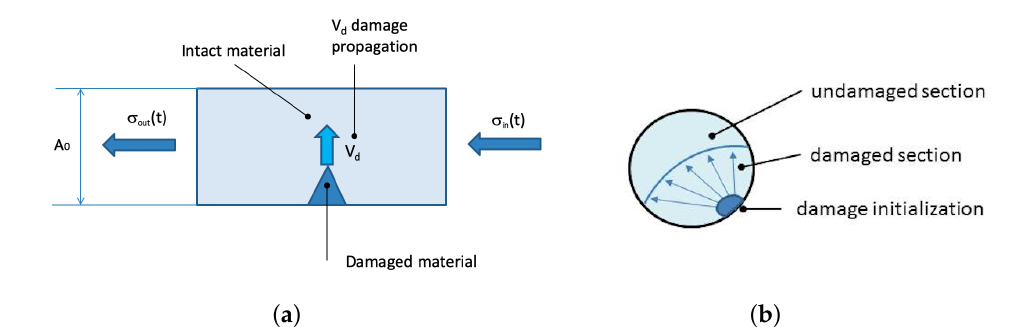
Figure 3. Damage propagation: ( a ) on specimen during a dynamic test; ( b ) on the